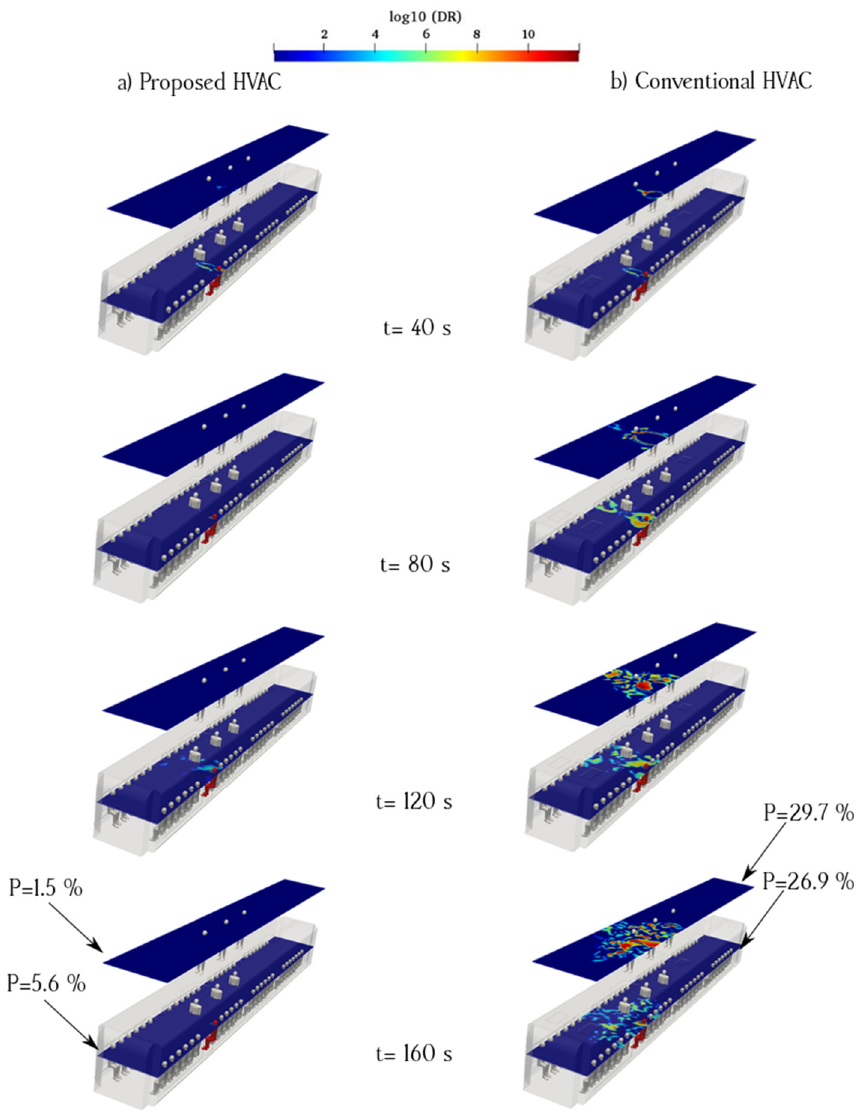
Figure 14. Time evolution of the counters of log 10 (DR) when the infected individual is sitting near the recirculated ducts of the proposed ( a ) and conventional ( b ) HVAC systems (Case